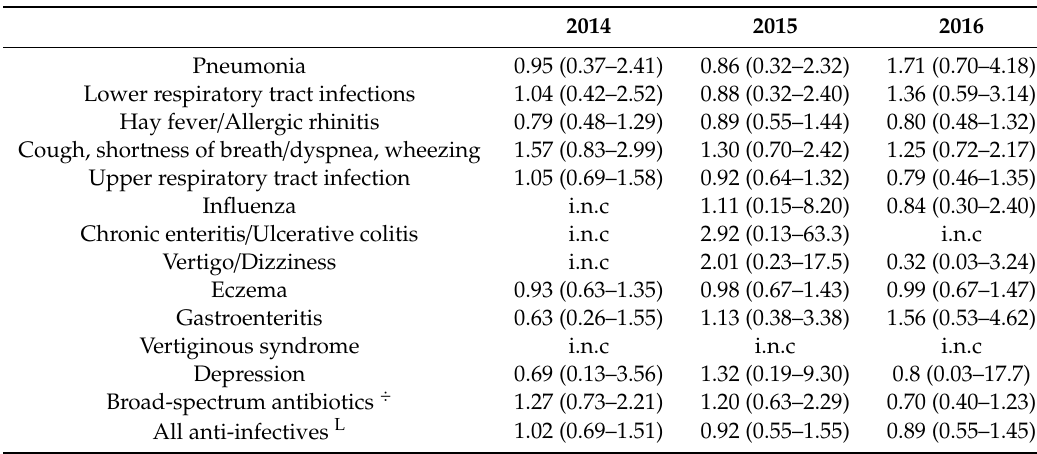
Table A13. Di ff erences (OR, 99% CI) a per year between livestock dense areas and control areas among children with asthma b .